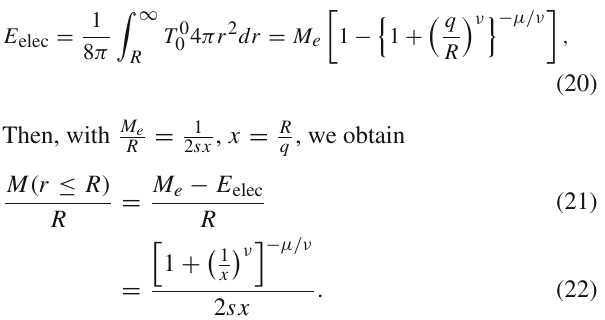
Fig. 4 Behavior of f ( x ; s ) for fixed values of parameter s < s c and w = 0 . 05, μ = 3 ,ν = 2